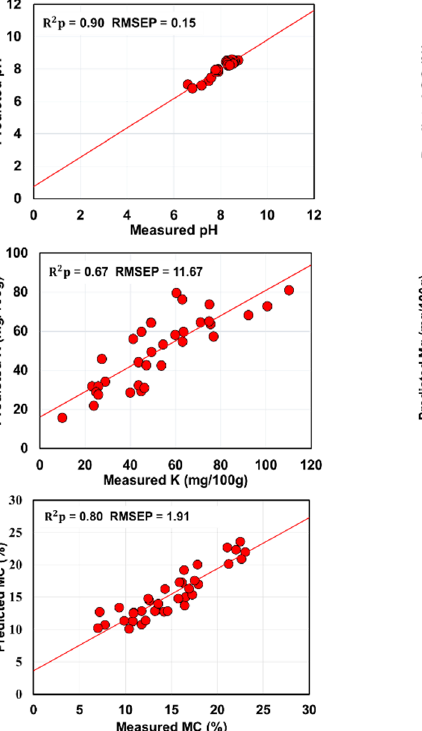
Figure 4. Predicted vs. measured scatter plots of best spectra fusion method (SF-SOPLS) for predicting seven soil attributes in test-set. Units of RMSEP are the same as units of respective soil properties.